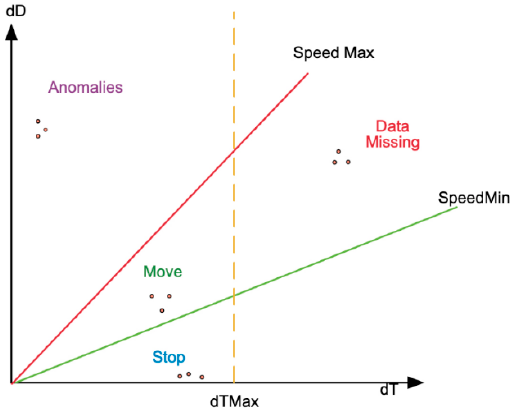
Figure 3. Scatter plot schematics.